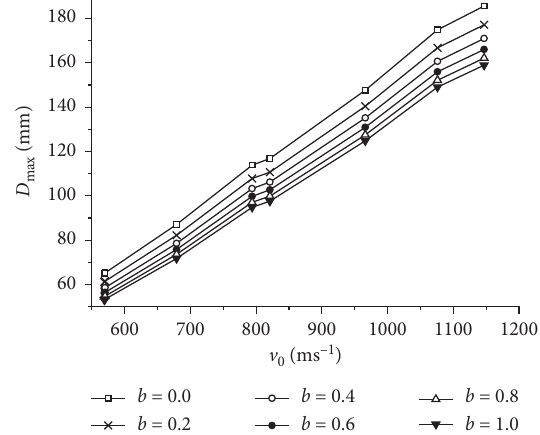
Figure 5: Comparison of penetration depth for different values of b